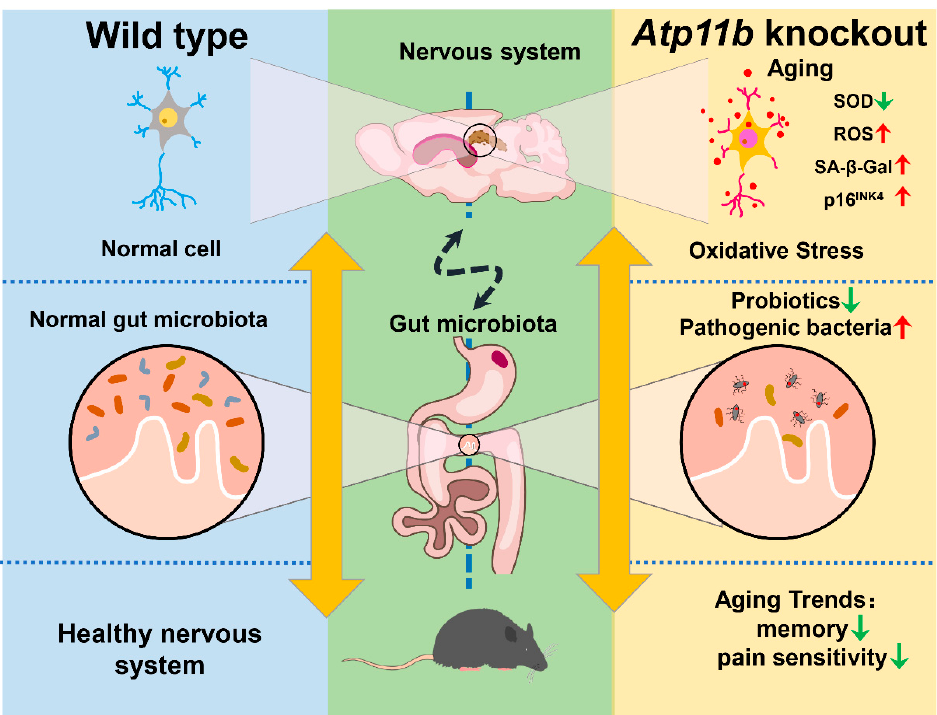
Figure 7. Schematic of the induction of gut microbial dysbiosis and acceleration of brain aging following Atp11b deletion. Gut microbial dysbiosis in Atp11b -KO mice accelerates brain aging, which manifests as an increased oxidative stress response in neurons and aging behaviors such as memory impairment and perceptual retardation.